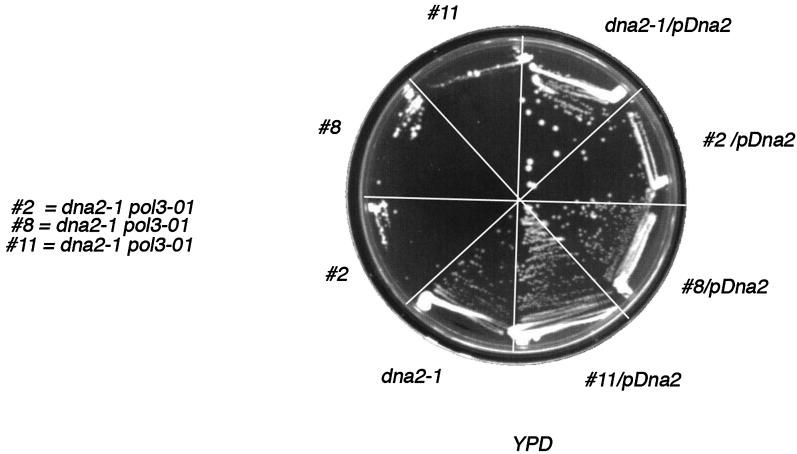
Synthetic Lethality Between dna2 and pol3–01
Strain W303 dna2–1 carrying a TRP1 CEN3 DNA2 plasmid was transformed with an integrating URA3 pol3–01 plasmid [120] cut with BamH1. The transformants were streaked on 5-FOA medium to excise the WT POL3 gene and identify clones with the pol3–01 mutation. Three transformants carrying the pol3–01 mutation (isolates 2, 8, and 11) were restreaked on YPD medium containing 2-amino-5-fluorobenzoic acid (FAA), which selects for strains that have lost the DNA2 TRP1–containing plasmid [121]. Three dna2–1 pol3–01 colonies showing some residual growth on the FAA plates were restreaked on YPD-containing medium. The same three isolates of dna2–1 pol3–01 but containing the DNA2 TRP plasmid, i.e., that had not been grown in the presence of FAA, are shown as controls, as indicated.